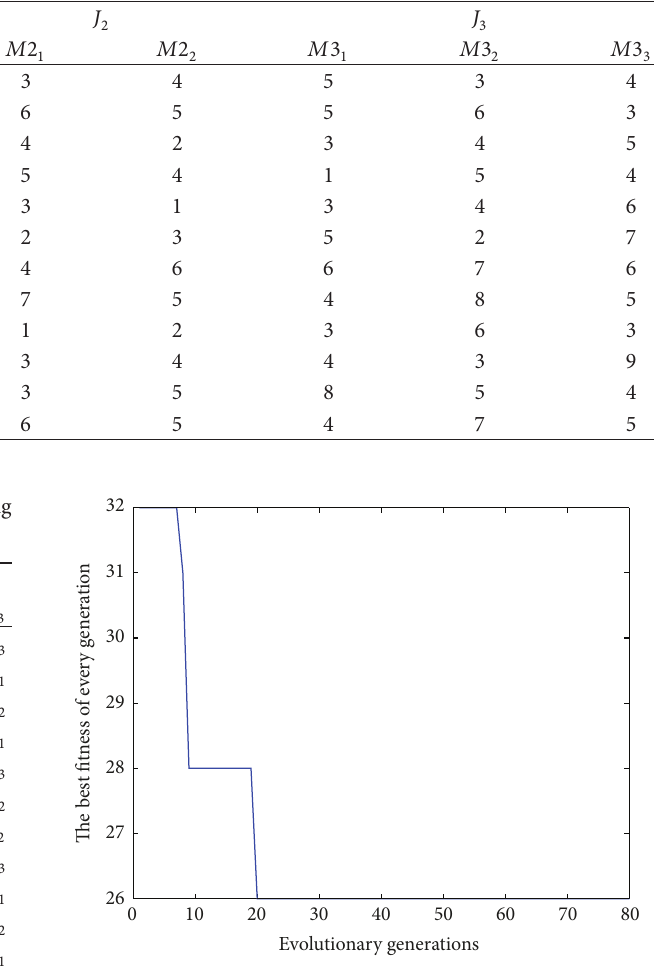
Figure 5: The changing curve of work time of the best individual in the population.